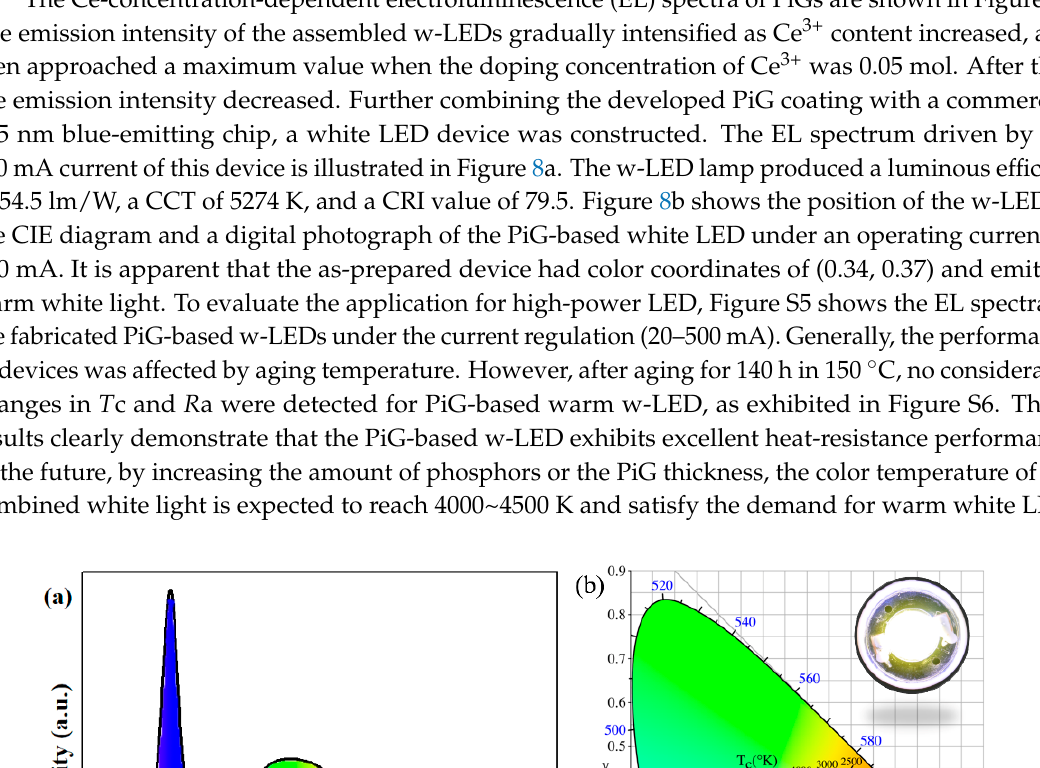
Figure 7. ( a ) Temperature-dependent PL ( λ ex = 455 nm) spectra of the as-prepared PiG sample. ( b ) Infrared thermal imaging picture of the as-prepared PiG sample.